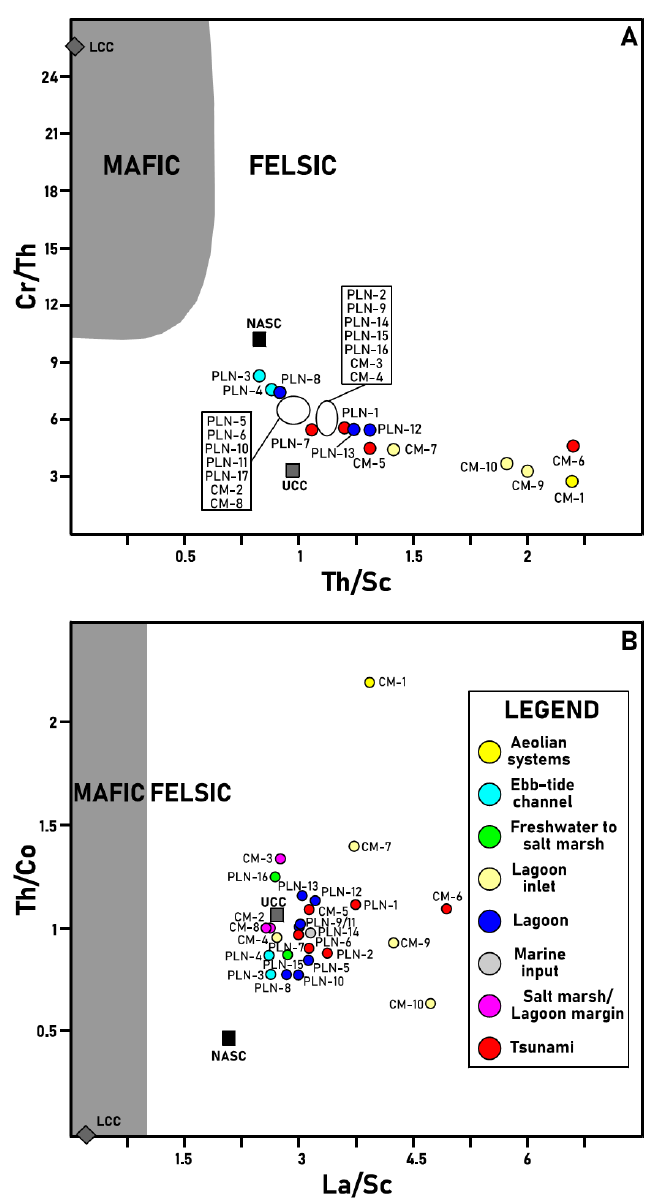
Figure 14. ( A ) Bivariate plot of Th/Sc–Cr/Th. ( B ) Bivariate plot of La/Sc–Th/Co.